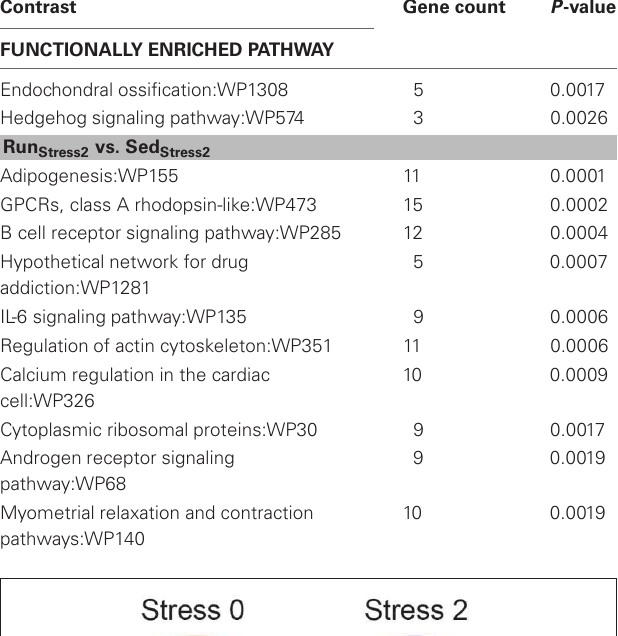
Table 3 | Functionally enriched KEGG and Wiki pathway